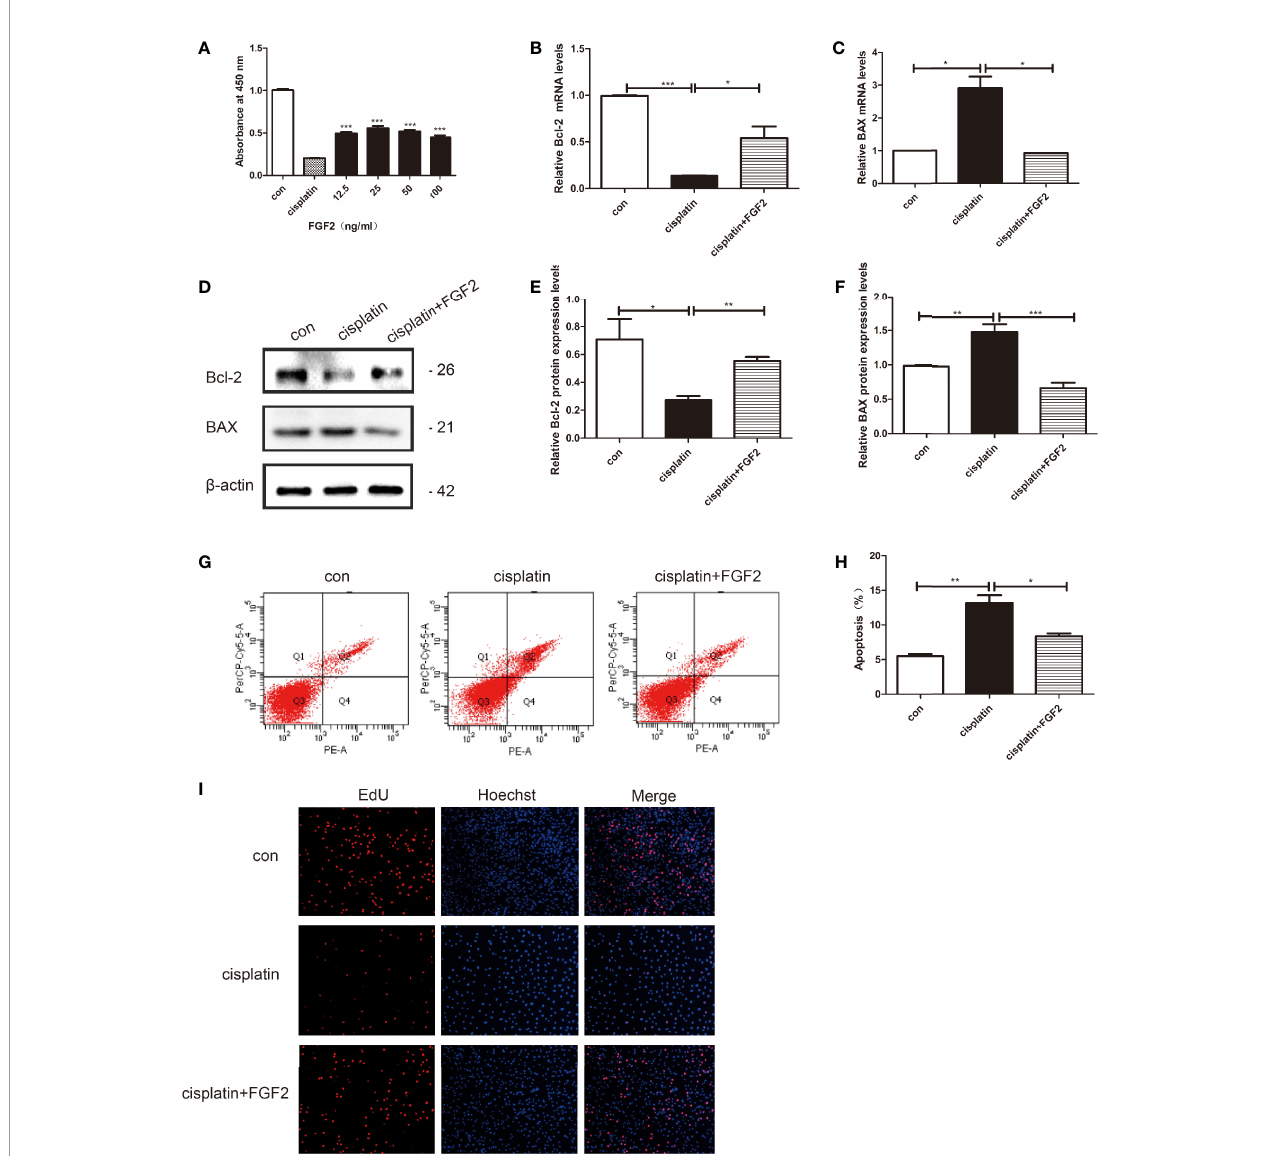
FIGURE 1 | FGF2 promotes cisplatin-induced injured granulosa cell proliferation and inhibits its apoptosis. Cisplatin-induced injured granulosa cell was generated by treating KGN cells with 10 m M cisplatin for 24 h. (A) CCK-8 assay was performed to measure the rate of injured KGN cell proliferation adopted with different concentrations of FGF2. The results indicated that treatment with 25 ng/ml FGF2 signi fi cantly increased cell viability. (B, C) The mRNA expression levels of Bcl-2 and BAX were assessed using qRT-PCR and normalized to GAPDH. (D – F) The protein expressions of Bcl-2 and BAX were determined by Western blotting with b -actin as a loading control. (G, H) Flow cytometry assays were performed to determine the effect of FGF2 on injured KGN cell apoptosis. A quantitative analysis of the rate of apoptosis was performed. (I) EdU labeling assay was used to detect cell viability. Hoechst was used as a DNA/nuclear stain. One-way ANOVA followed by Tukey ’ s multiple comparison test. The results were shown as mean ± SEM from 3 independent experiments ( a = 0.05, * P < 0.05, ** P < 0.01, *** P < 0.001). FGF2, Fibroblast Growth Factor-2; CCK-8, Cell Counting Kit-8; qRT-PCR, Quantitative Real-Time PCR; EdU, 5 ‐ Ethynyl ‐ 2 ‐ Deoxyuridine